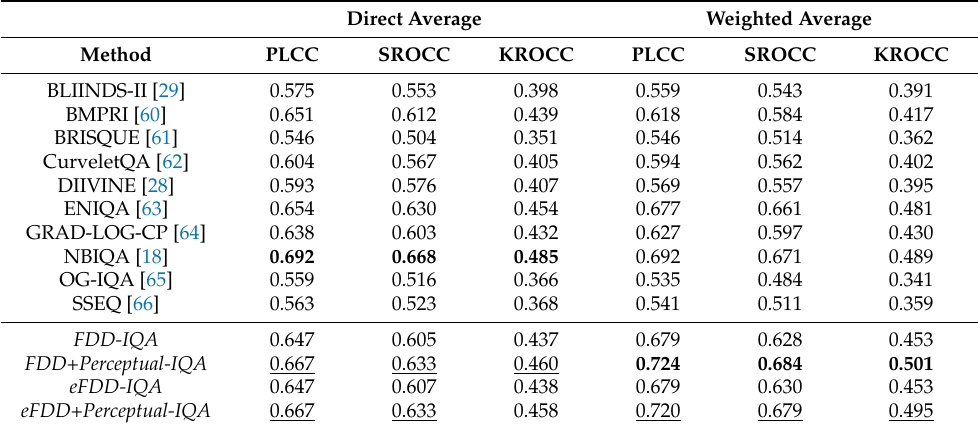
Table 13. Comparison of FDD-based NR-IQA methods to the state-of-the-art. Direct and weighted average of PLCC, SROCC, and KROCC values are reported. Best results are typed in bold, second best results are underlined.